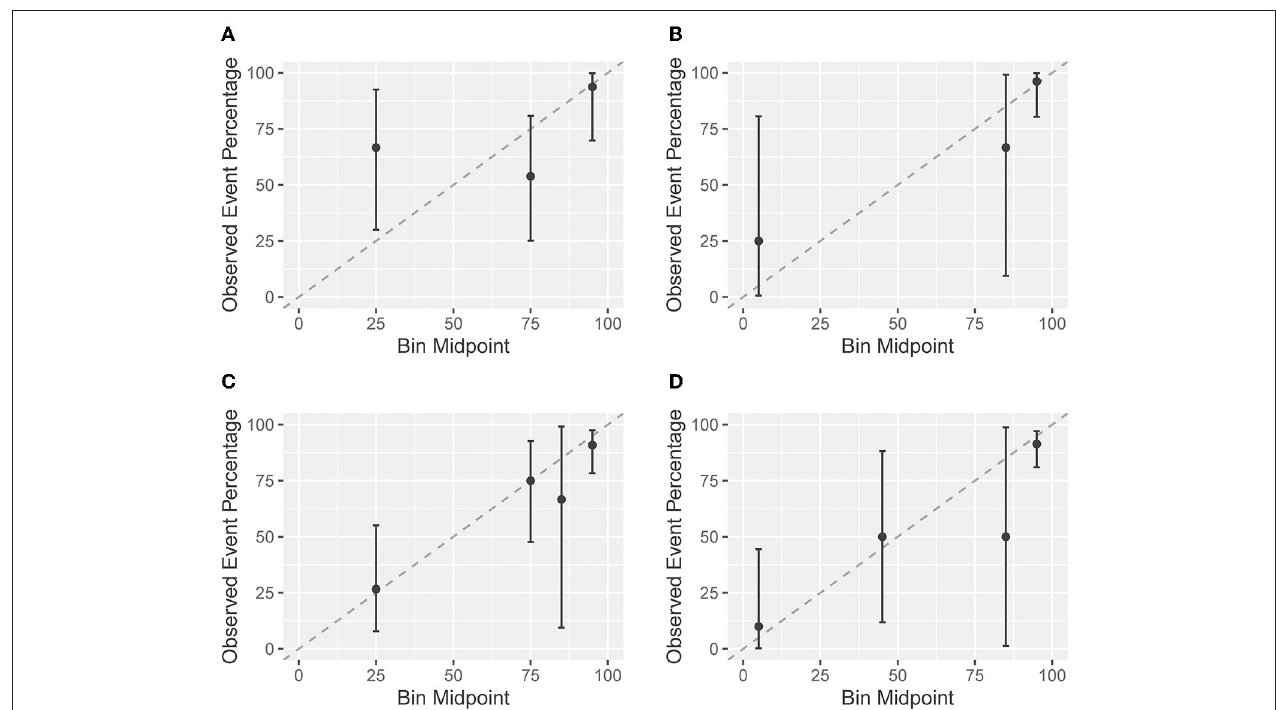
FIGURE 3 | Calibration plots based on the imputed datasets. A calibration plot shows the agreement between the predicted probabilities based on the Early Prediction of Functional Outcome after Stroke (EPOS) model for independent gait on the x -axis and the in the observed probabilities of validation cohorts on the y -axis. The closer the points are to the plotted diagonal line, the better the calibration. Points above the diagonal line indicate that the model is rather pessimistic, points below the line indicate that the model is rather optimistic. Confidence intervals (CIs) overlapping with the diagonal 45 degree line indicate no significant difference between predicted and observed probabilities. Cohort I: (A) the EPOS model for day 2, measured on day 1 post-stroke; and (B) the EPOS model for day 9, measured on day 8 post-stroke. Cohort II: (C) the EPOS model for day 2, measured on day 3 post-stroke; and (D) the EPOS model for day 9, measured on day 9